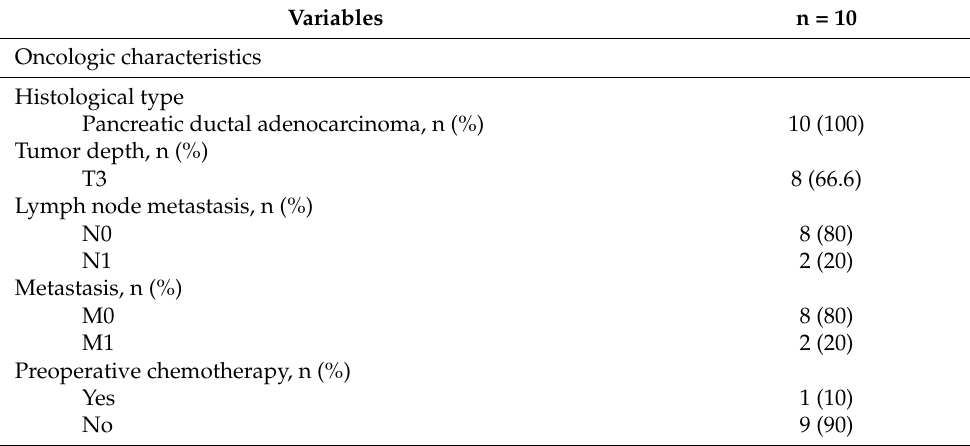
Table 1. Cont. Variables n = 10 Oncologic